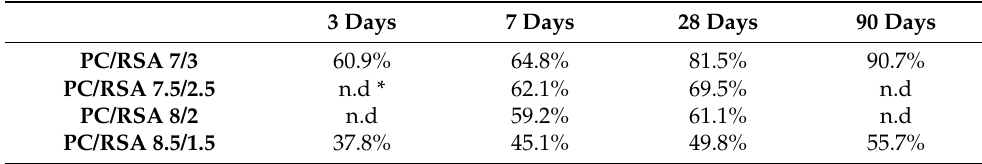
Table 5. Fixed CH percentages for pastes